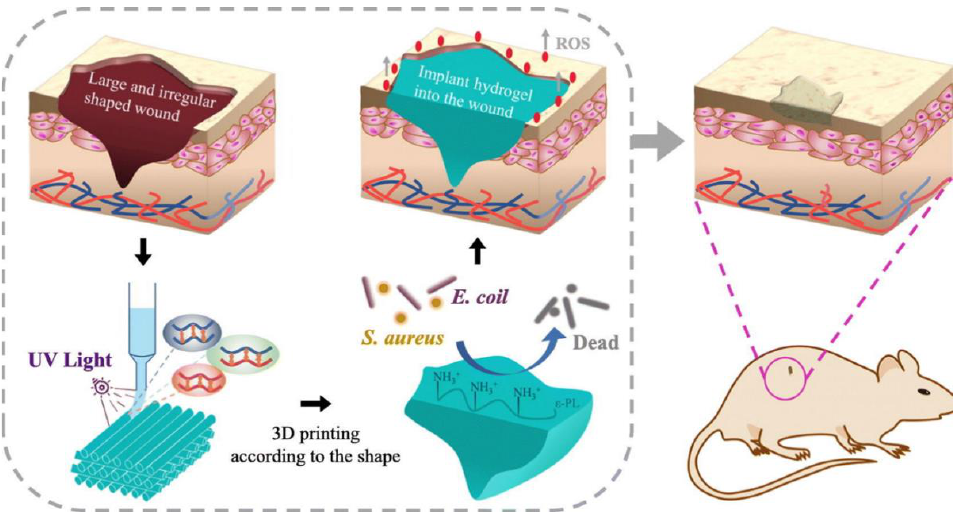
Figure 3. Bioprinting of geometrically complex hydrogel for chronic wound treatment, including conjugated polylysines for antibacterial effects and reduction of reactive oxygen species (ROS) at the wound site. Adapted with permission from [42], 2021, Wang et al.